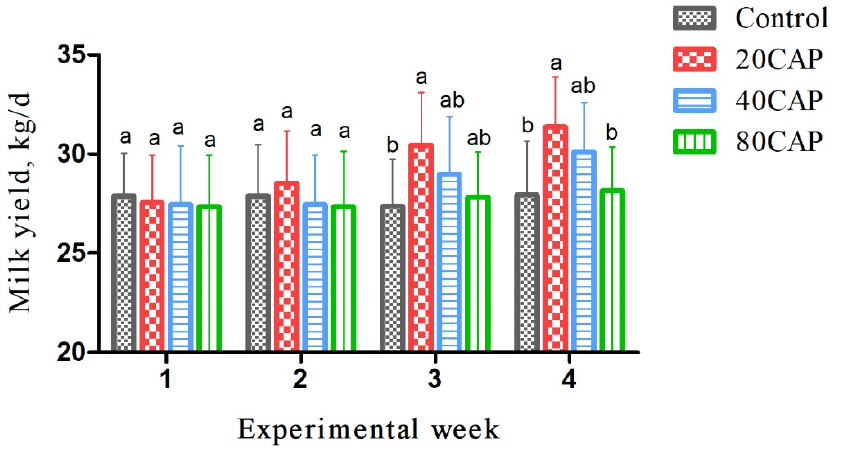
Figure 2. Change in milk yield throughout the study for cows fed a basal diet (control) or basal diet supplemented with 20 (20CAP), 40 (40CAP), or 80 (80CAP) mg of CAP/kg of dry matter. Bars indicate the standard error. Different letters (a, b) indicate the significant difference ( p < 0.05).